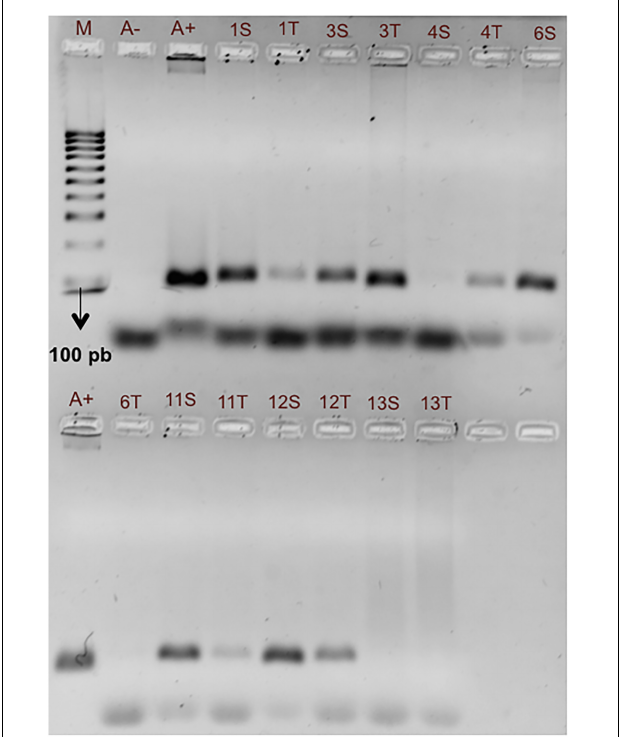
FIGURE 5 | PCR amplification of samples from seven different stations in Todos Santos Bay region using AOST123F and AOST123R primers. The 89 bp fragment indicates the presence of A. ostenfeldii . Results of samples collected on March 1, 2017 are presented. The samples were collected at surface (S) and thermocline (T) in the water column. A+: positive PCR control and A–: negative PCR control. M: molecular marker of 100 bp